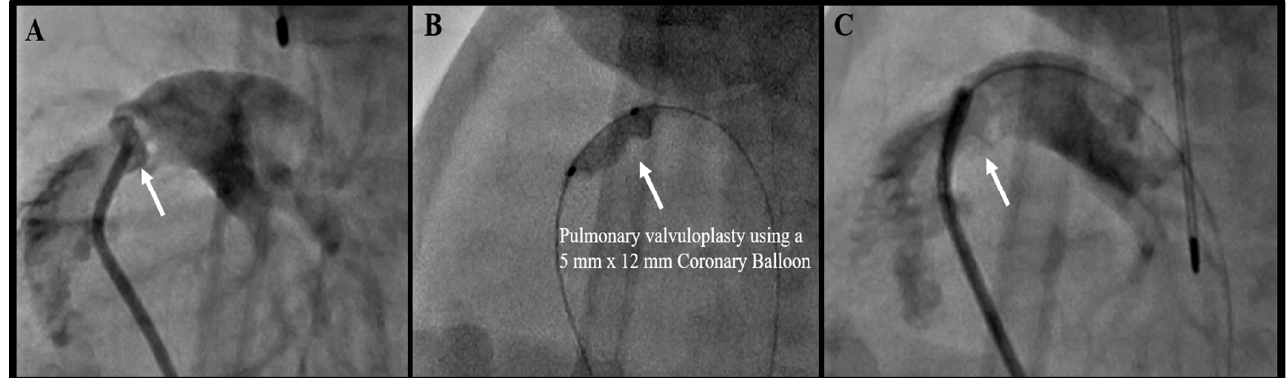
Figure 1. Angiograms of a Pulmonary Valvuloplasty in a 900-gram Infant. ( A ) Angiogram showing a dysplastic, thickened pulmonary valve. ( B ) Balloon angioplasty of the pulmonary valve with an obvious “waist.” ( C ) Post-balloon angioplasty angiogram of the pulmonary valve.